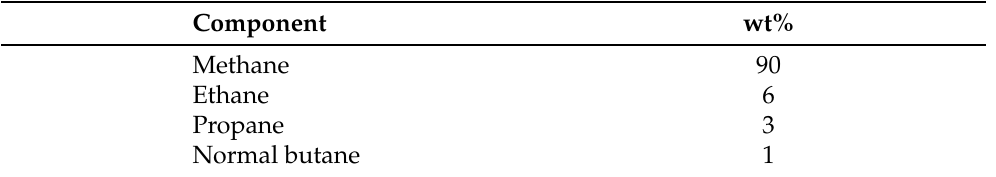
Table 1. LNG composition used in calculations.